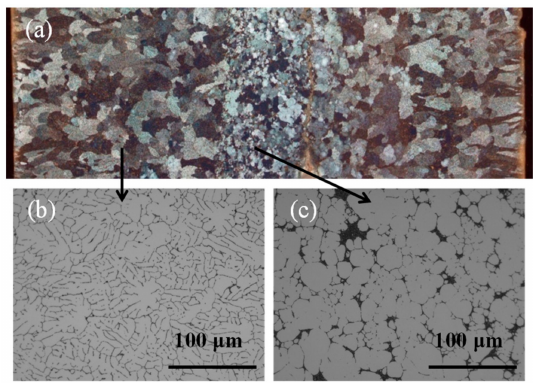
Figure 4. ( a ) Anodized grain structure, and normal etched microstructures of ( b ) the outer shell, and ( c ) the central band region.